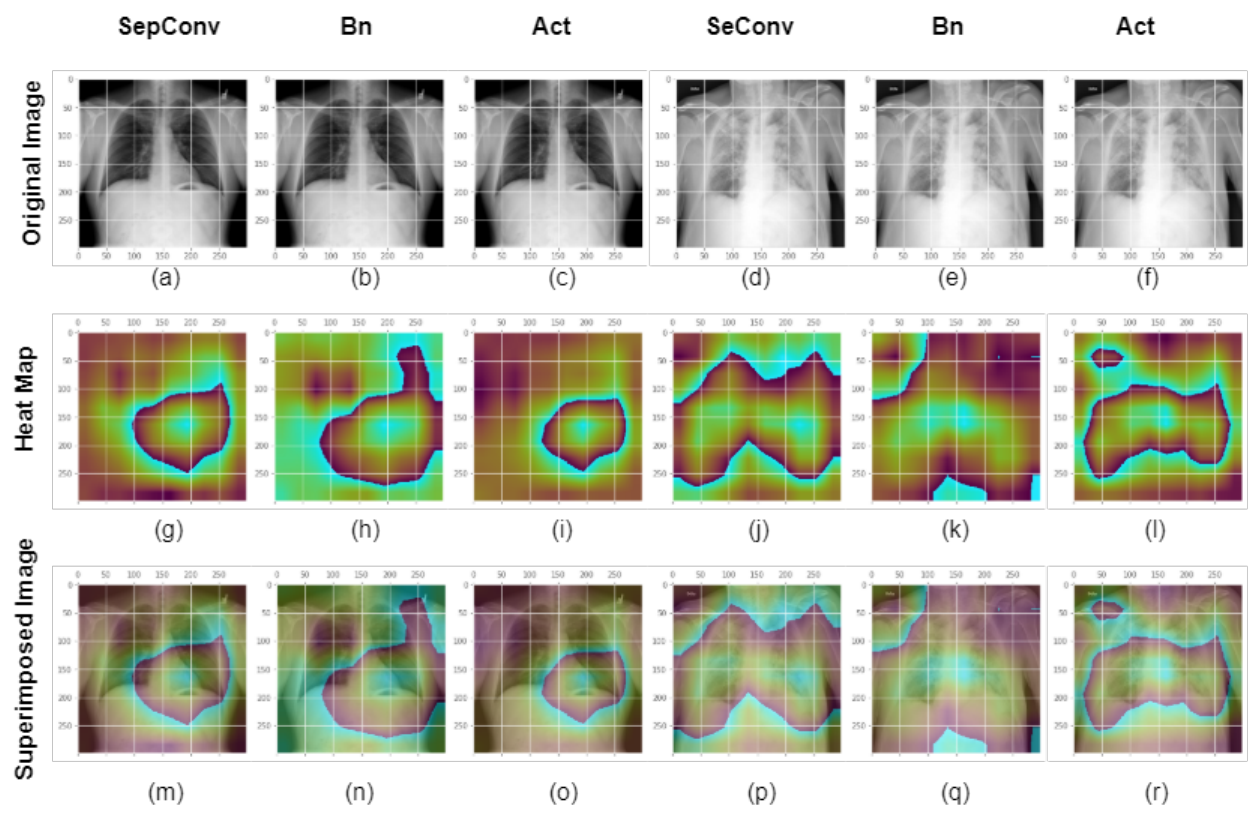
Figure 15. GradCam analysis utilizing the Xception model of COVID and normal class images at several levels in a single block. Chest X-ray image from the COVID and normal classes are presented in the first row or in images ( a – f ). Images ( g – l ) or the second row depicts the xray image’s GradCam activation mapping. The X-ray image in the third row or images ( m – r ) is positioned on an activation map to display the superimposed image. The input image, heatmap, and overlay image of the block14 separation convolution 2, batchnormalization, and ReLu activation layers of the Xception model for a normal class image are shown in the first three columns. The original picture, activation mapping, and overlaid images of block14 separation convolution 2, batchnormalization, and ReLu activation layer for a COVID class image for the Xception model are shown in the latter third of the column. The Activation layer contributes more to the decision making